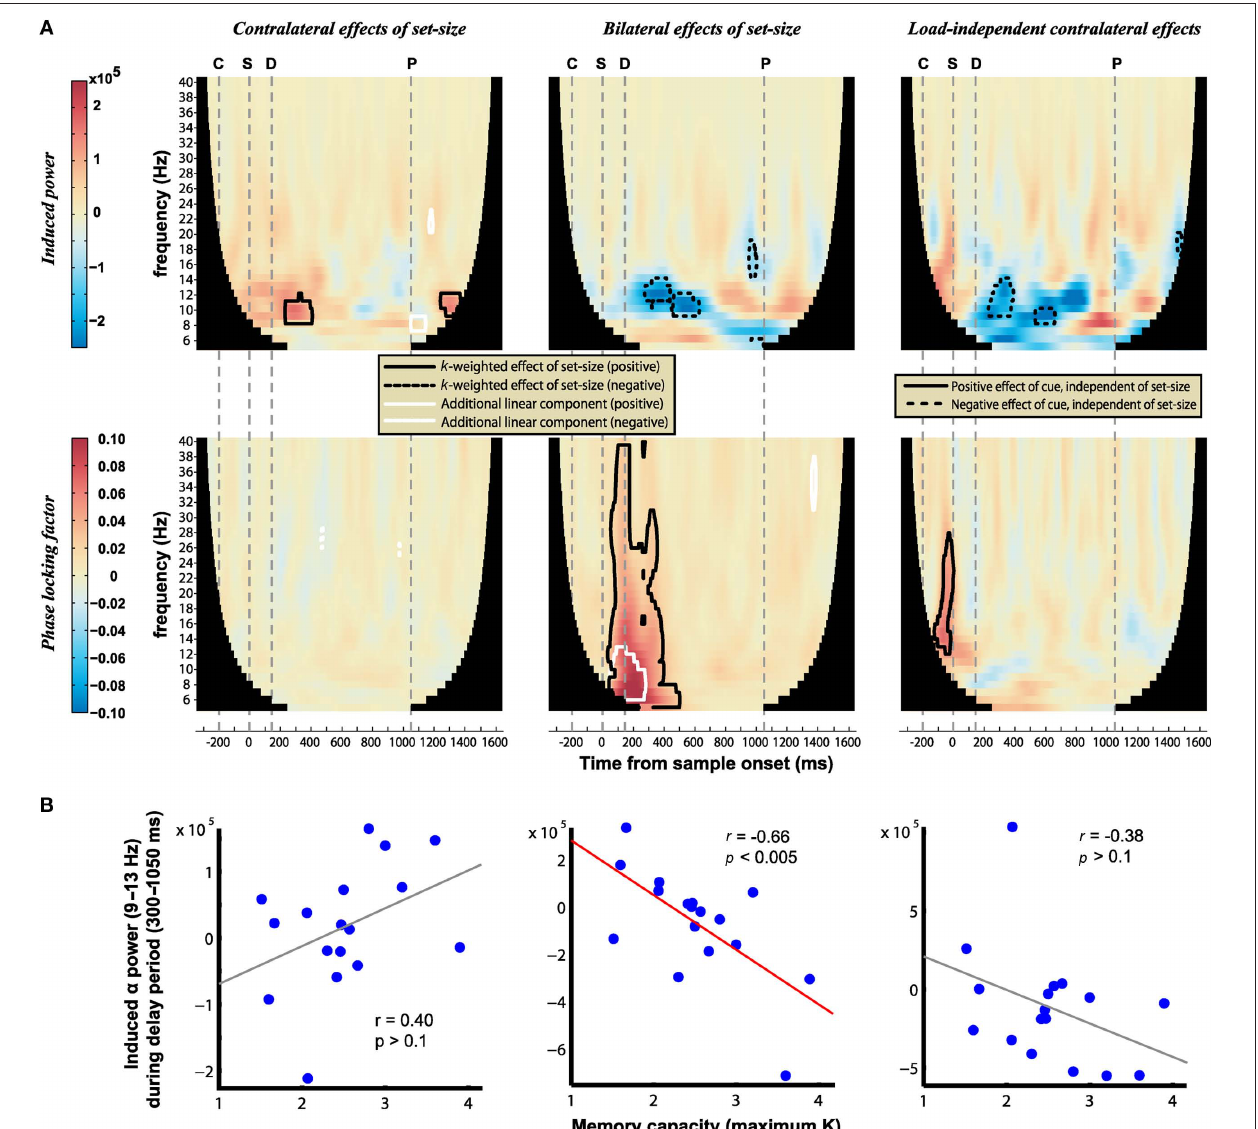
Figure 6 | (A) Power (top) and phase-locking (bottom) of induced oscillations. Warm hues correspond to signals that increase with K contralateral to the cued hemifield (left column), increase bilaterally with K (middle column), or increase contralaterally regardless of load (right column). Contours identify regions where contrasts are significantly different from baseline levels (posterior